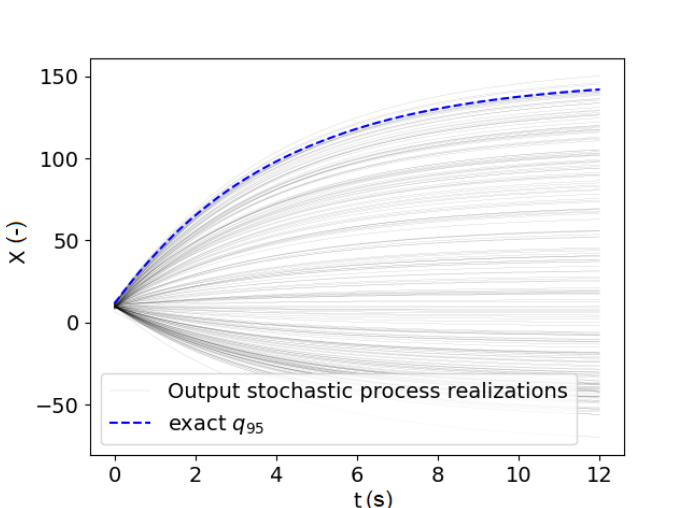
Figure 4. Realizations of output stochastic process samples and exact q 95 quantile.